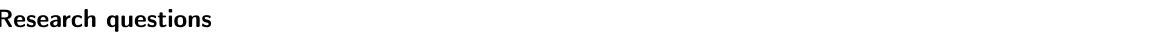
Table 1: Study research